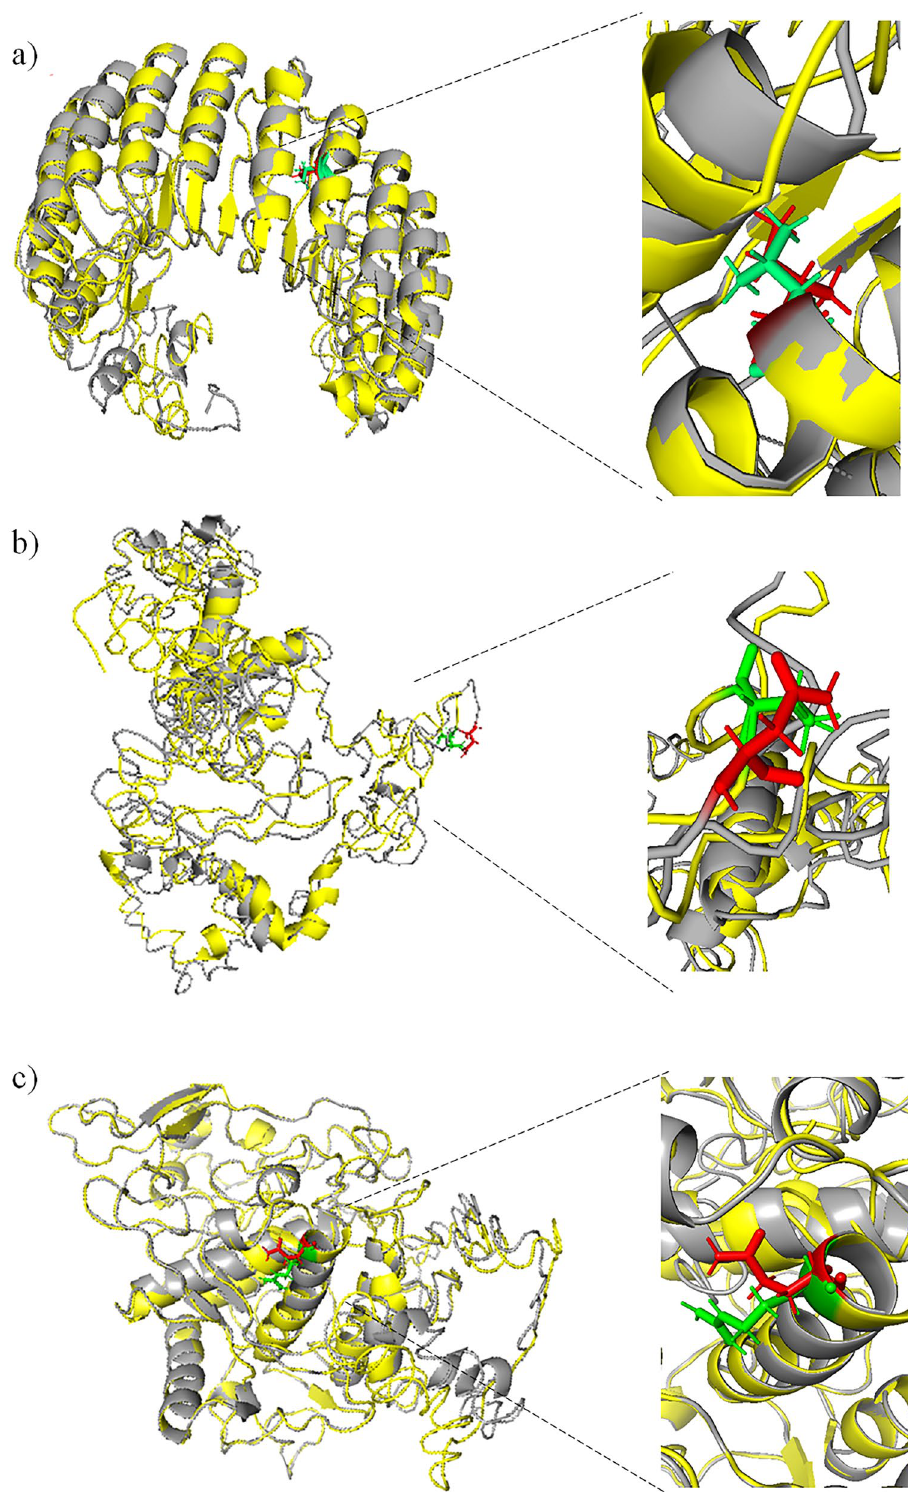
Figure 2. Graphical representations of amino acid changes due to the most deleterious nsSNPs and close-up view for substitution of amino acids (green = native residue; red = mutant residue). ( a ) Superimposed structures of native LRRC34 protein and its mutant with substitution from Leucine to Isoleucine at position 286. ( b ) Superimposed structures of wild type FARP2 protein and its mutant having substitution from Threonine to Asparagine at position 260. ( c ) Superimposed structures of the native TYR protein and its mutant having substitution from Arginine to Glutamine at position